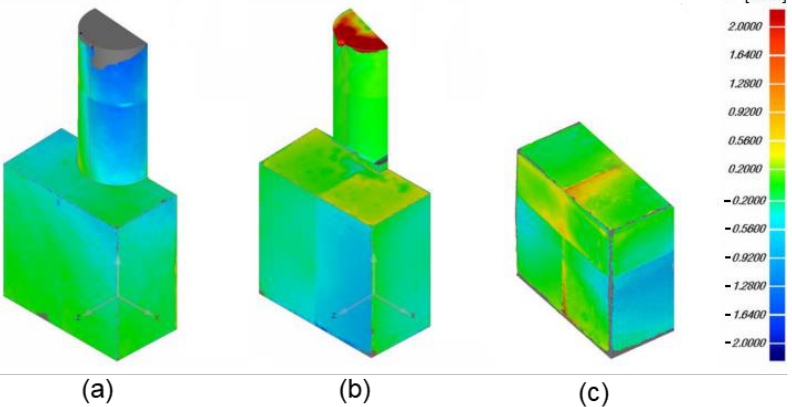
Figure 12. Scanning results of the prototypes poured at 1250 °C: ( a ) Prototype A3, smooth surface ( b ) Prototype B3, smooth surface; ( c ) Prototype C3, smooth surface.